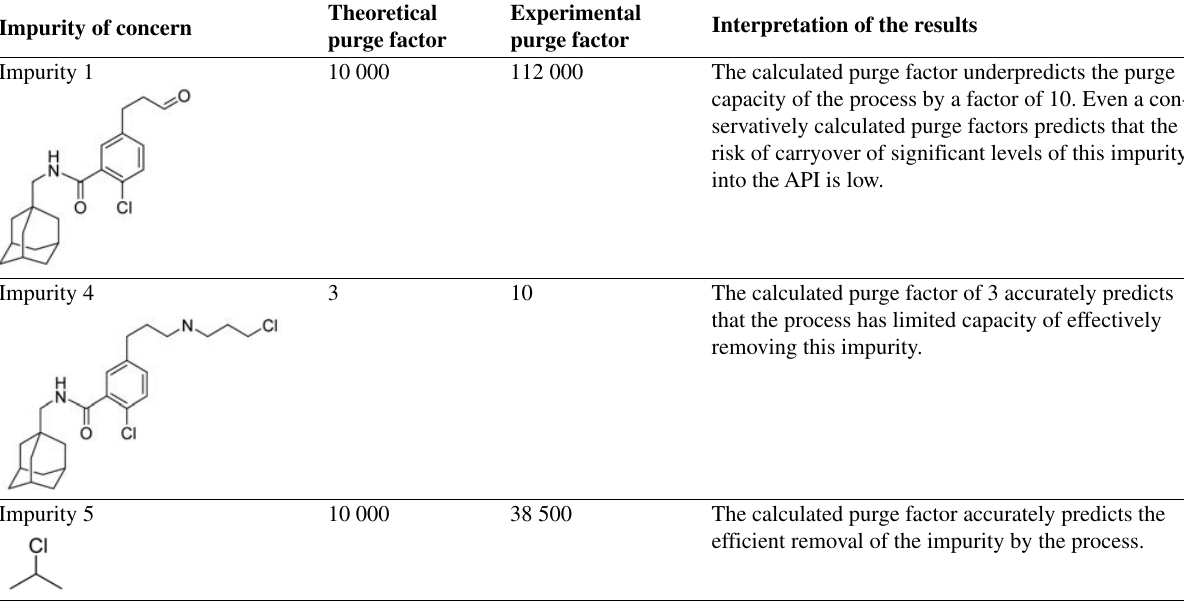
Table 4. Summarized results of the case study for the synthesis of AZD9056 (based on Teasdale et al. 28 ).